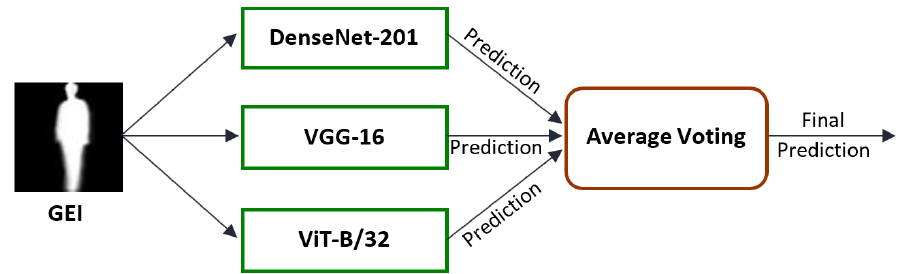
Figure 1. Architecture of the ensemble method.